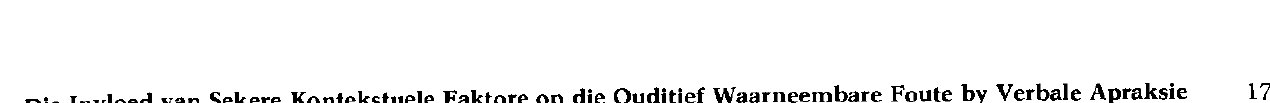
Tabel 5: Rangskikking van foutkategoriee in dalende volgorde van foutvoorkoms by die verskillende klankstruk-